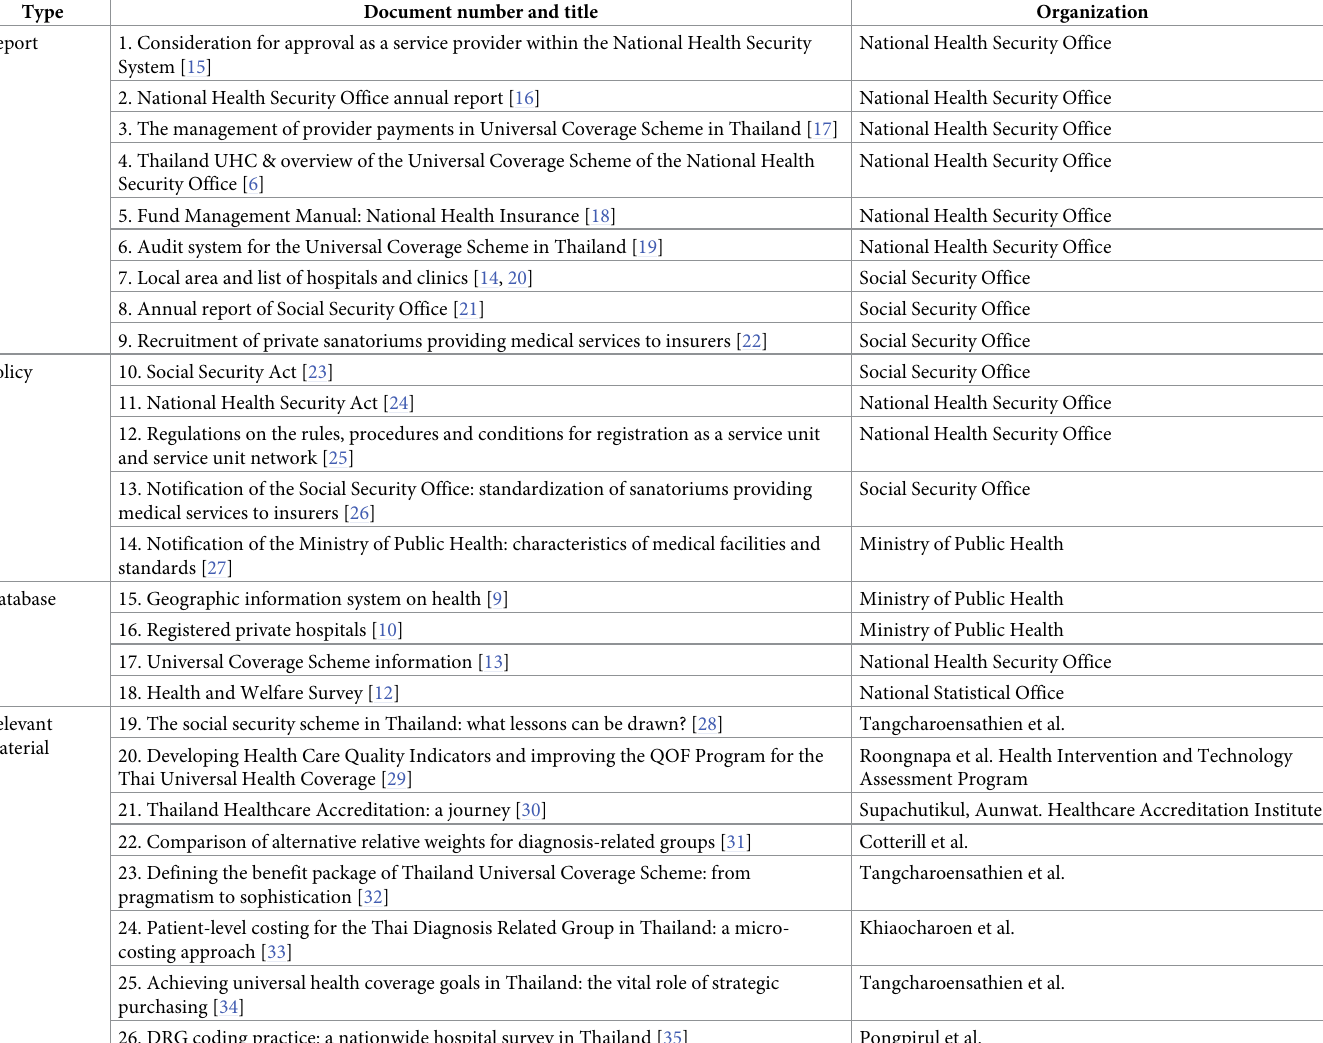
Table 2. Documents relevant to contracting private health facilities in UHC.